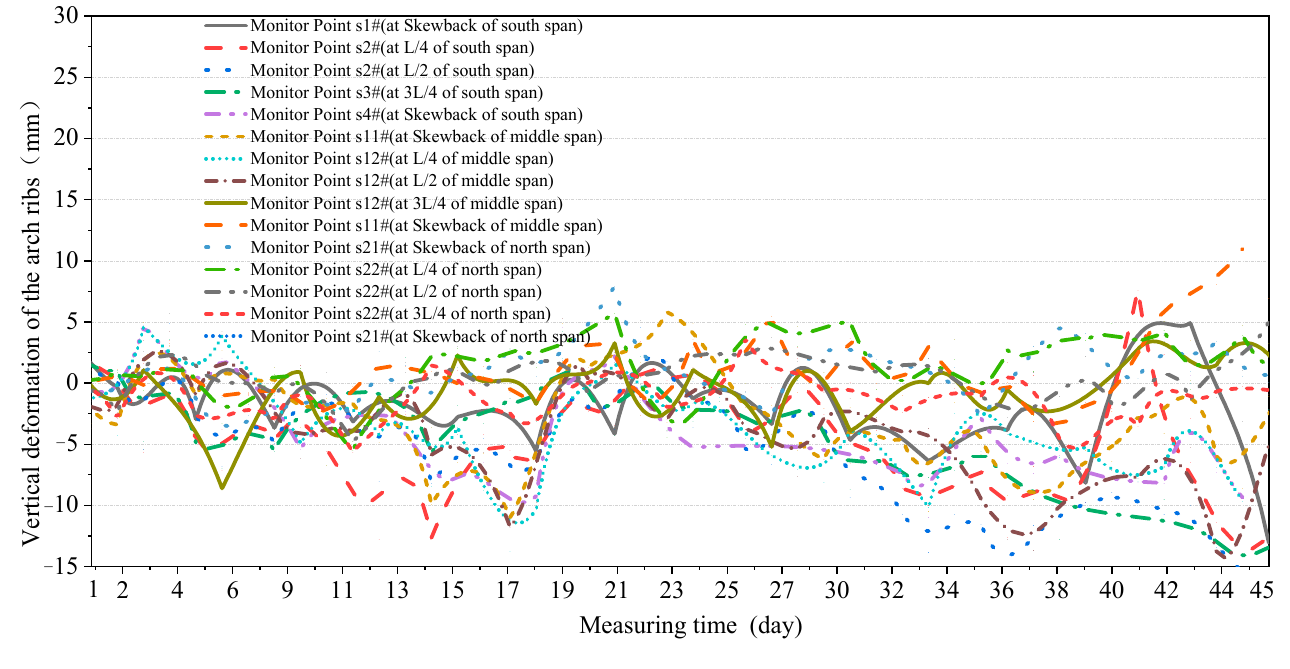
Figure 13. Monitoring results of vertical deformation of arch ribs.